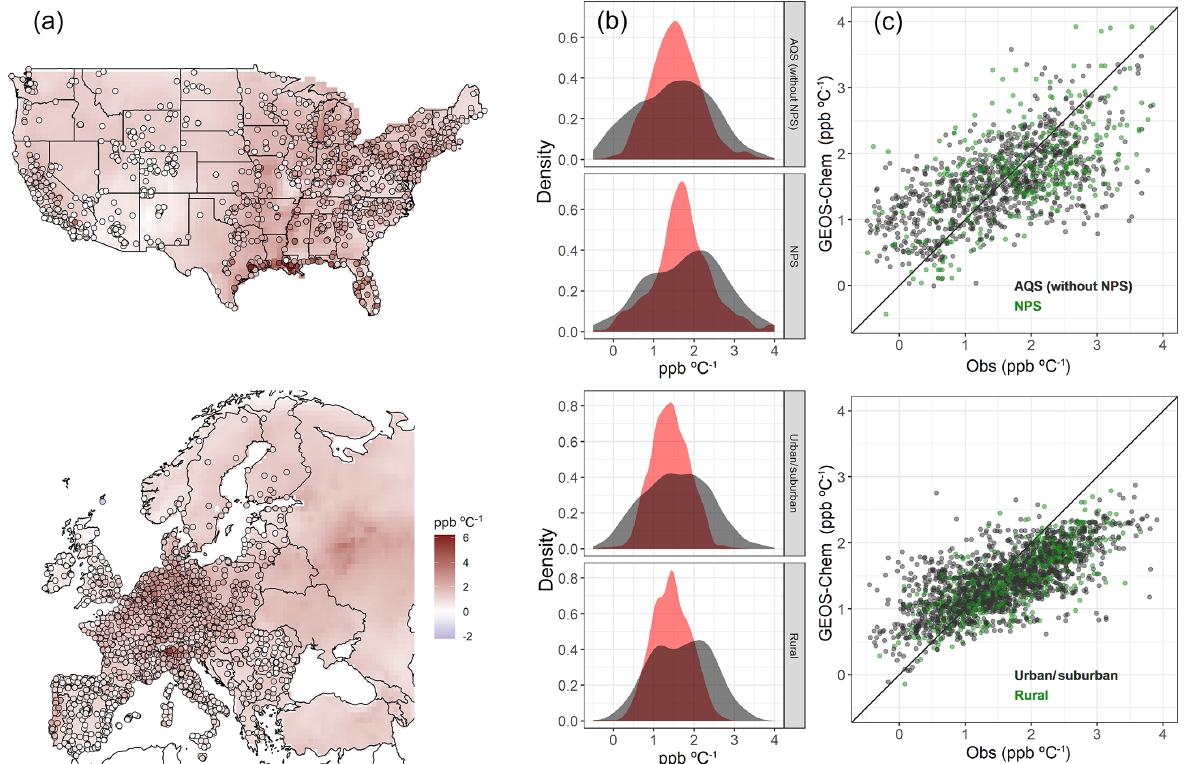
Figure 4. Regression slopes of summer (JJA) daily maximum 8h average O 3 vs. daily maximum temperature for GEOS-Chem and station observations in the United States and Europe. Station data points are overlaid on gridded model output in panel (a) . Distributions for observed (black) and modeled (red) O 3 – T slopes are shown in panel (b) , further separated by station category: US stations are separated between the more remote NPS stations and the remaining stations of the AQS network, while European stations are split by AirBase area category into urban/suburban and rural station types. Scatterplots in panel (c) show modeled values vs. observed, with green points used to mark NPS stations in the US and rural area stations in Europe. The remaining AQS stations, as well as those AirBase stations categorized as urban or suburban, are shown as black